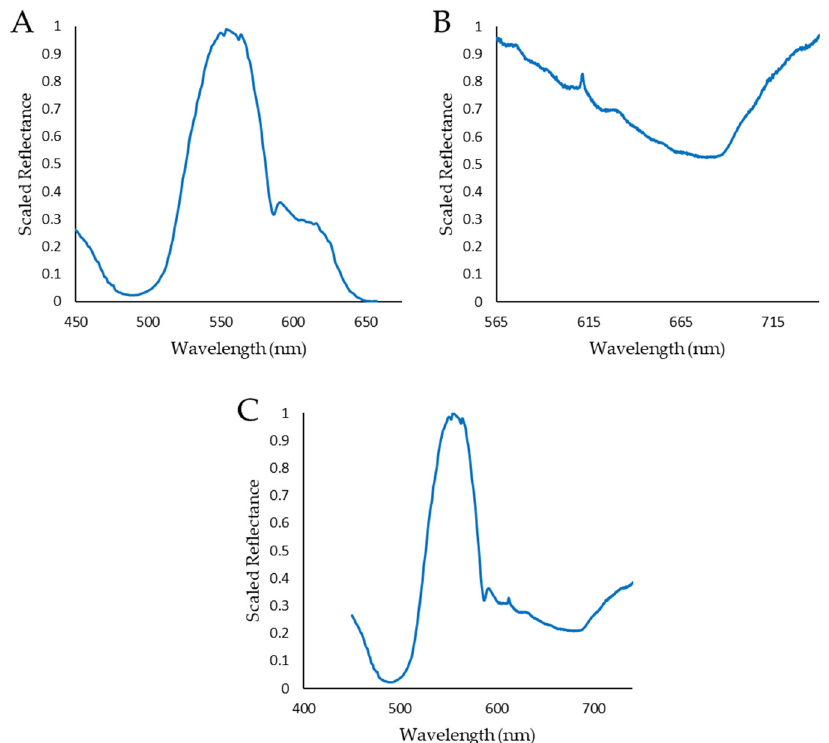
Figure 5. Example dataset combination. ( A , B ) show the individual spectral responses captured by the Hyperspectral Smartphone and the Low-Cost High-Resolution instrument, respectively. ( C ) shows the full dataset after combination. Note, the relative intensities remain accurate after combi-